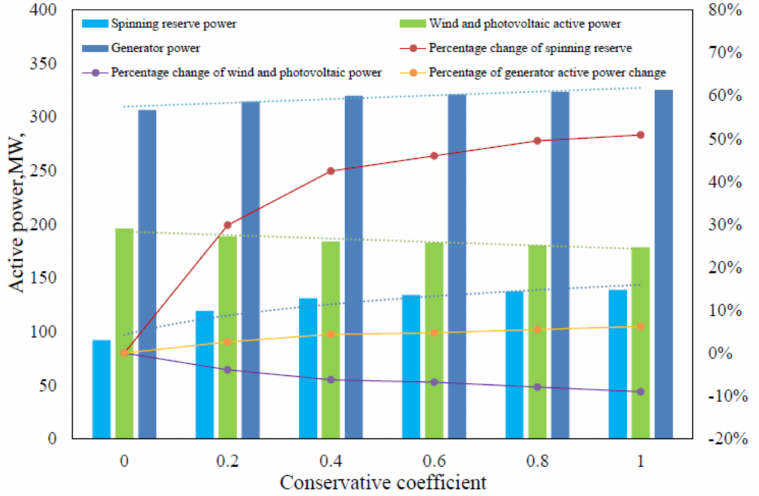
Figure 5. Variation of generator and wind power with different conservative coefficient.